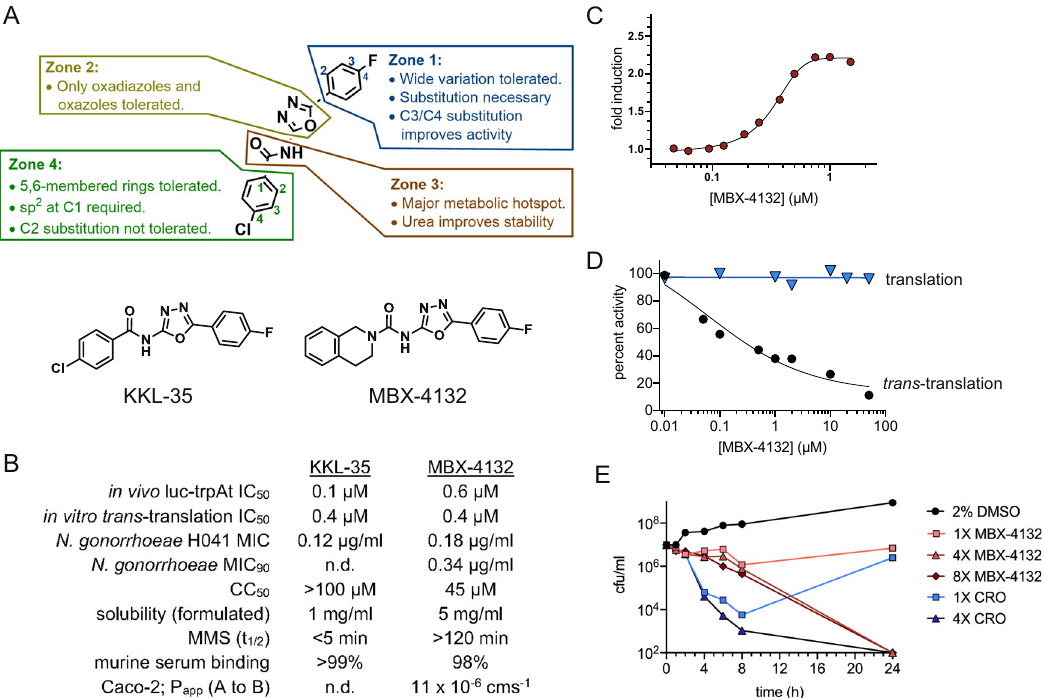
Fig. 1 Optimized acylaminooxadiazoles inhibit trans -translation to kill N. gonorrhoeae . A Zones used to guide synthetic strategy with characteristics that govern activity are indicated, and the structures of KKL-35 and MBX-4132 are shown. B Properties of the initial hit, KKL-35, and optimized inhibitor MBX- 4132 (CC 50 – half-maximal cytotoxic concentration against HeLa cells; MMS – murine liver microsome stability). C Inhibition of trans -translation in E. coli cells was monitored using a non-stop luciferase reporter. The average of two biological repeats is shown. D Inhibition of trans -translation in vitro was assayed using an E. coli S12 extract to express a truncated, non-stop nano-luciferase gene in the presence of a mutant tmRNA that added the remainder of the nano-luciferase protein. Trans -translation activity resulted in luminescence, and addition of MBX-4132 inhibited the reaction (black). As a control, a full- length nano-luciferase gene was used to demonstrate that MBX-4132 does not inhibit translation (blue). The percentage of activity compared to activity in absence of MBX-4132 is shown from the average of at least two repeats. E Time-kill assays using N. gonorrhoeae show that MBX-4132 is bactericidal at ≥ 4X MIC. Ceftriaxone (CRO) was used as a control. Counts below the detection limit (100 cfu/ml) were plotted at 100 cfu/ml. Source data are provided as a Source Data fi